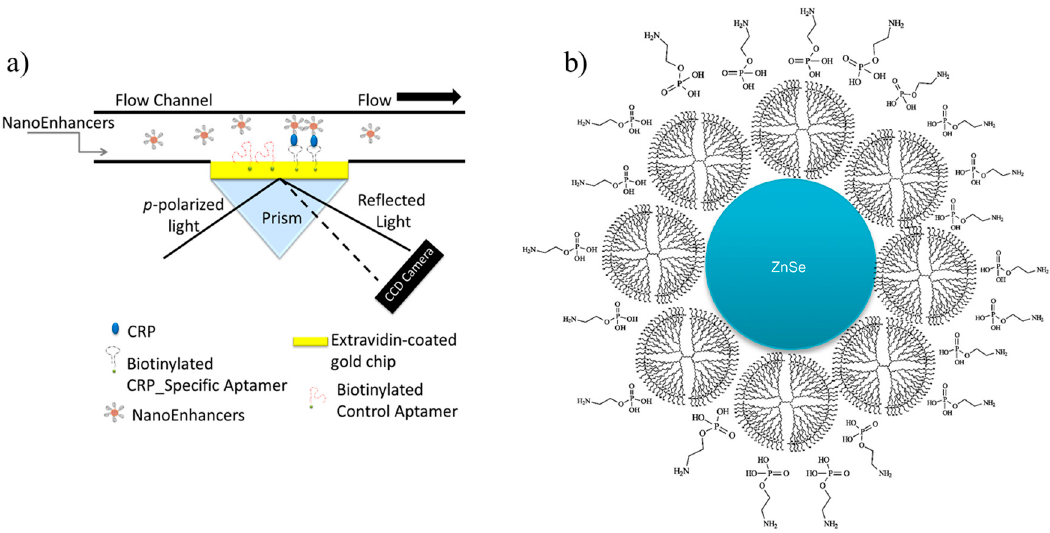
Figure 2. ( a ) Schematic view of the SPR chip with biotinylated aptamers coated by NIR-QDs (nanoenhancers) ([72], licensed under CC BY 3.0); ( b ) schematic view of the S-DAB–ZnSe–PEA QDs nanocomposite (Reprinted with permission from